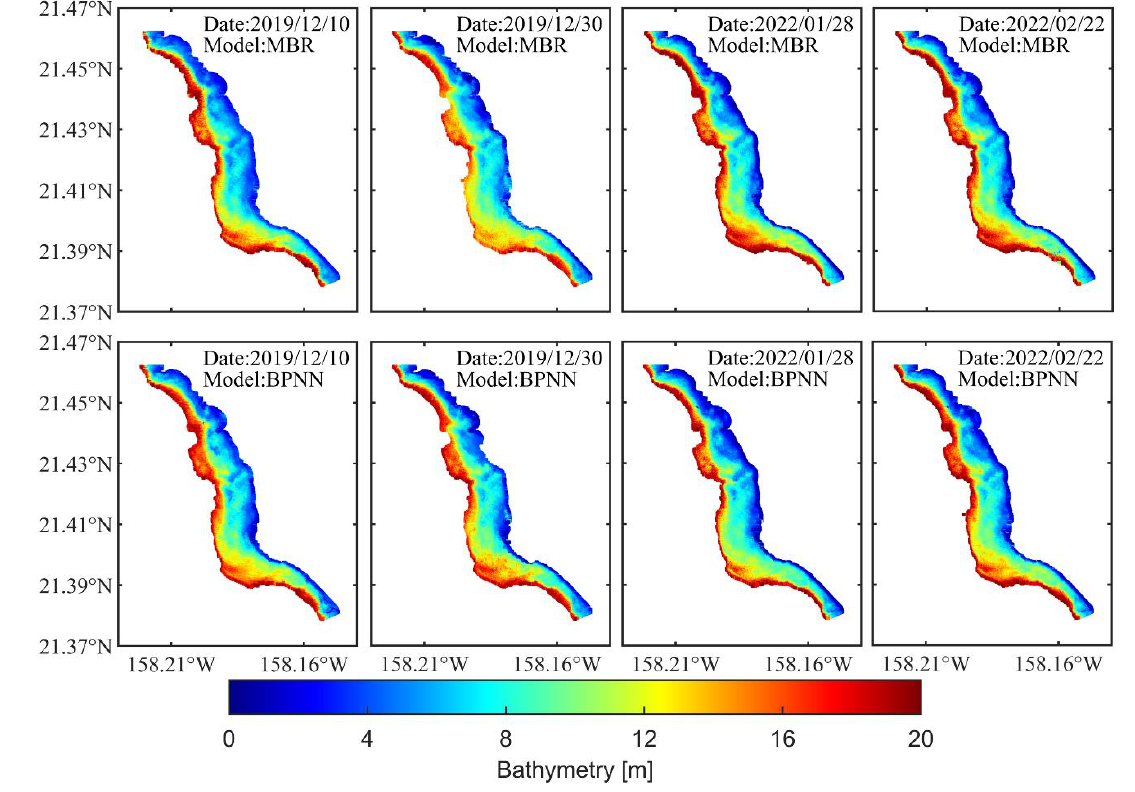
Figure 14. SDB derived from four Sentinel-2 images by multiband ratio model and BP neural network model. The multi-band ratio models are as follows. Table 3. Validation results of SDB in the Oahu area.